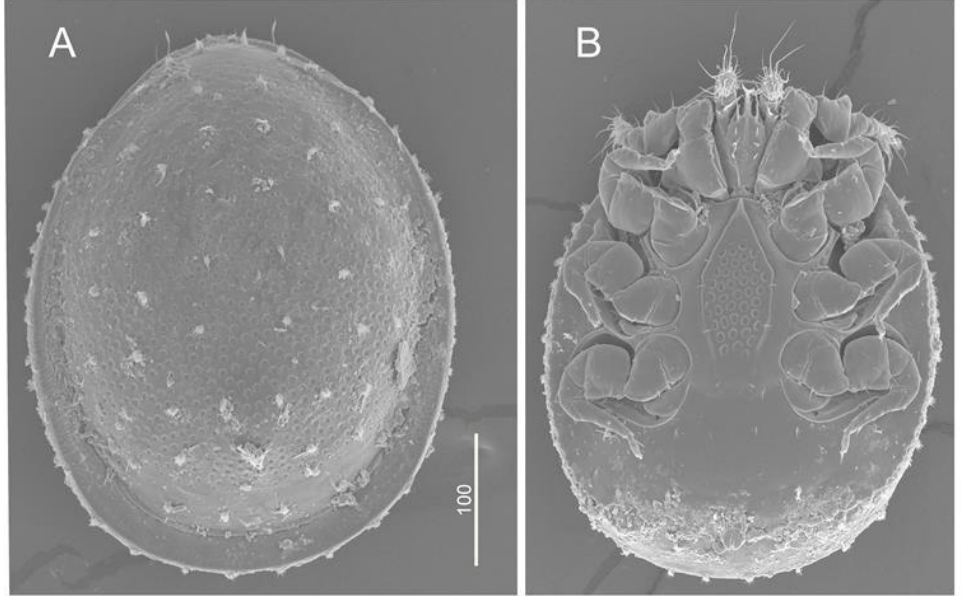
Figure 10. Penicillaturopoda pennicillata , female from Ecuador: ( A ) dorsal side, ( B ) ventral side.